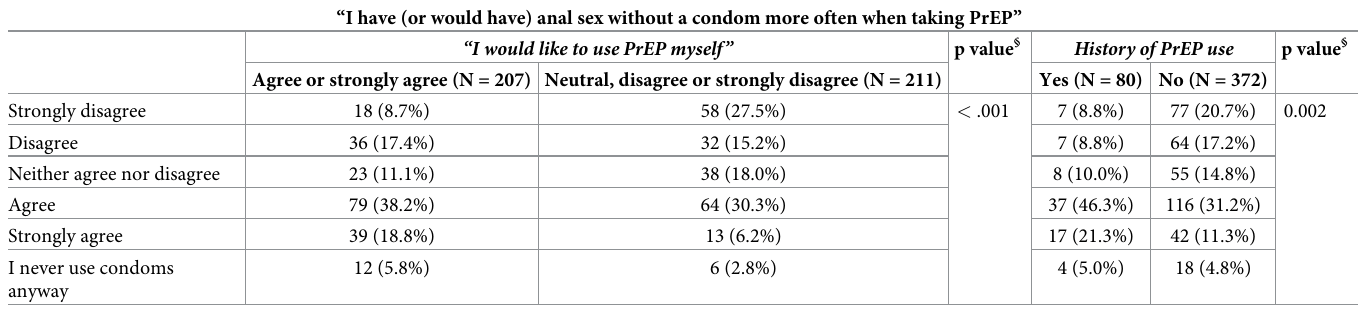
Table 6. Anticipated impact of taking PrEP on participants’ use of condoms, by desire to use PrEP and history of PrEP use. “I have (or would have) anal sex without a condom more often when taking PrEP” “I would like to use PrEP myself” Agree or strongly agree (N = 207) Neutral, disagree or strongly disagree (N =